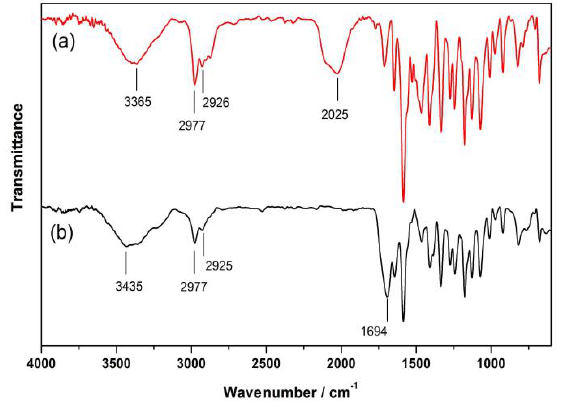
Figure 5. FTIR spectra of ( a ) RhB and ( b ) RhB-conjugated AOA.